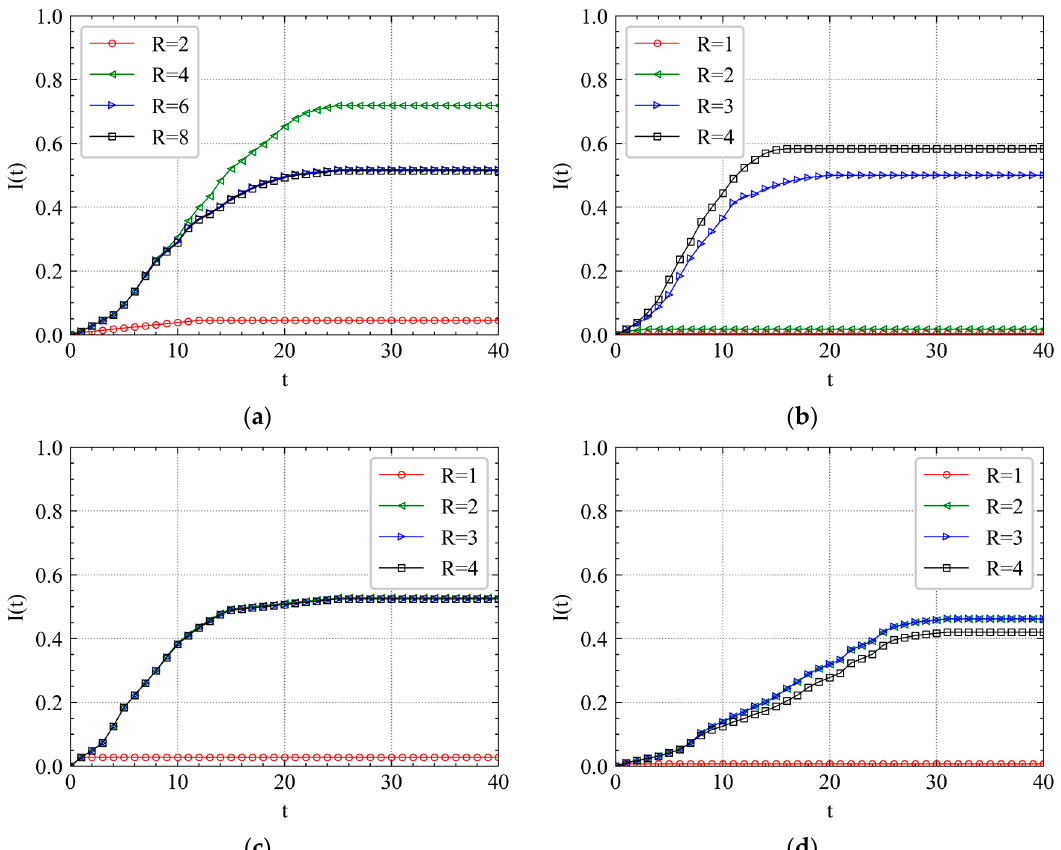
Figure 6. Cascading failure spreading scale analysis of April’s first Wednesday morning peak. ( a ) RA, ( b ) SRS, ( c ) CA, and ( d ) XZ.